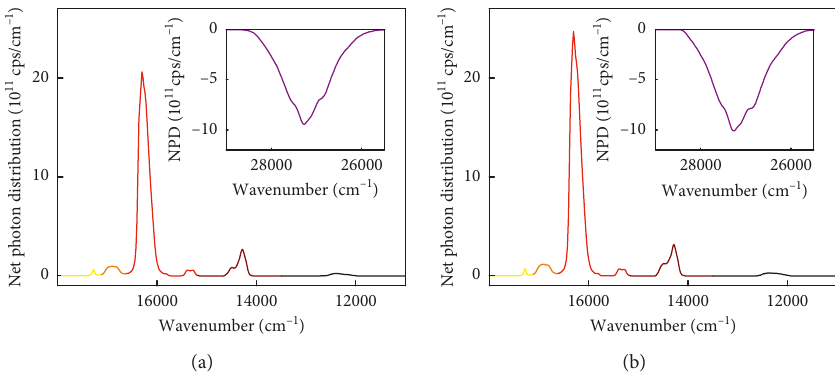
Figure 9: Net photon distributions of Eu(BA)(TTA) Insets: details of the absorption photon distributions. Table 1: Absorption, emission photon number, and quantum yield in Eu(BA)(TTA) 367nm UVA-LED excitation. Samples